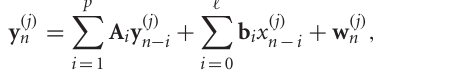
FIGURE 2 | Tukey-windowedmedian filtering for eliminating volume conduction artifacts. The upper trace depicts an example of raw data (blue solid line) and the Tukey-windowed median filter output (red dashed line). The lower trace depicts the weighting applied to the raw data (blue solid line) and the median filtered data (red solid line) to eliminate the volume conduction artifact.